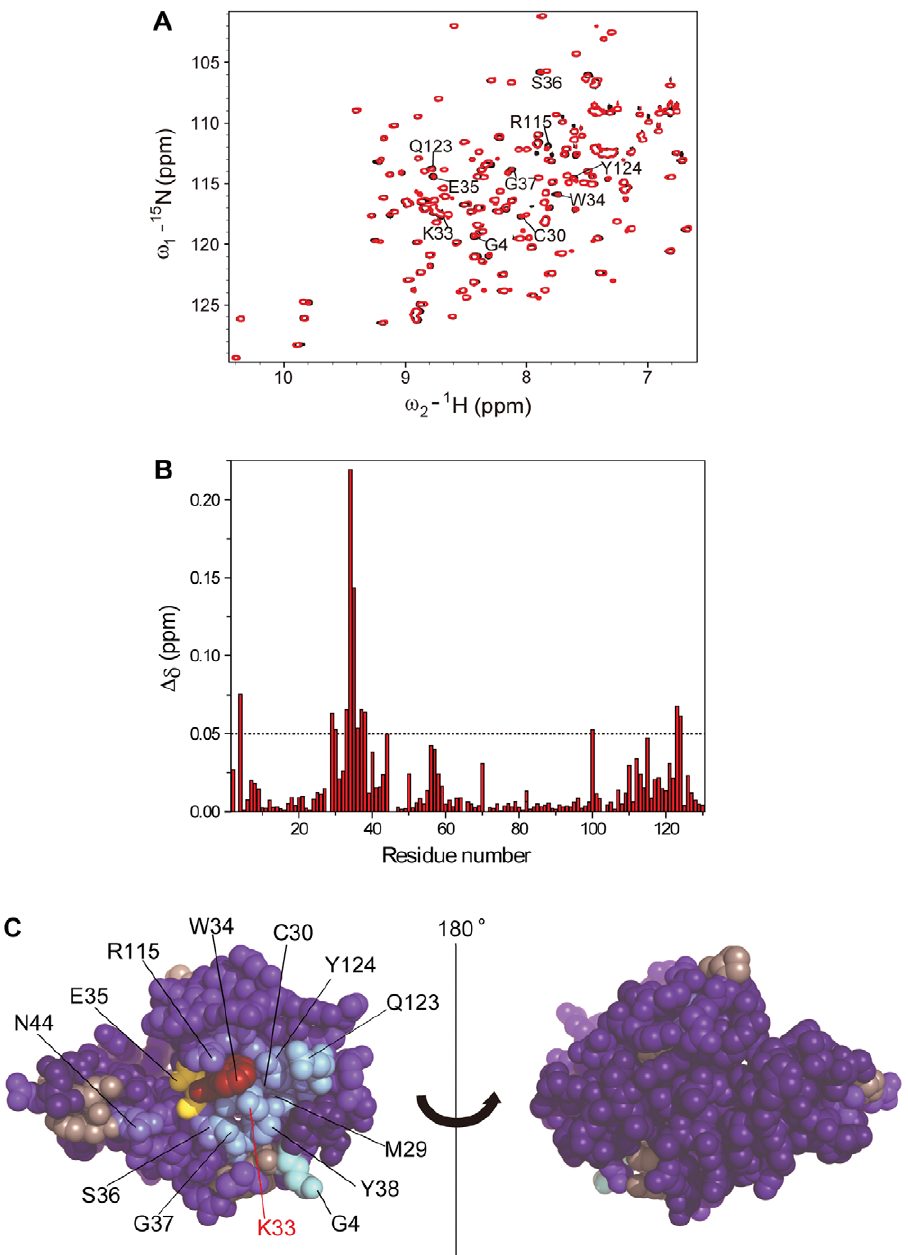
Figure 2. Mapping the location of modification by NMR spectroscopy. (A) Overlaid HSQC NMR spectra at 700 MHz of BioHuL (red) and WTHuL (blue); the spectra were collected at pH 5.0 and 37 u C (B) Chemical shift changes defined as [0.04( d 15 N WT 2 d 15 N Biotin ) 2 + ( d 1 H WT 2 d 1 H Biotin ) 2 ] 1/2 in BioHuL with respect to WTHuL [68]. (C) Structural identification of the BioHuL protein colour-coded by Dd value of each residue observed in (B) with the modified Lys33 labelled in red. Dark blue represents the lowest Dd value, whilst red represents the highest. Residues whose chemical shifts are most perturbed by the modification are identified. The black line in the centre of the two images represents the axis of rotation by 180 u . doi:10.1371/journal.pone.0050192.g002 by transmission electron microscopy (TEM), and the resulting images confirmed that the size and morphology of the fibrils formed by BioHuL are effectively identical to those formed by WTHuL. In addition, these fibrils clearly resemble those formed in previous studies where WTHuL fibrils were generated at pH of 7.5 (60 u C) [62]; in each case, the fibrils appear bundled and intertwined together with lengths around 1-2 m m and about 100 nm in thickness (Figure 3B).